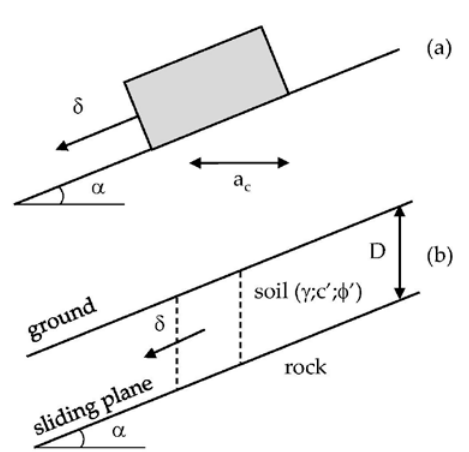
Figure 2: Analogy between (a) block resting on inclined plane and (b) landslide on an infinite slope